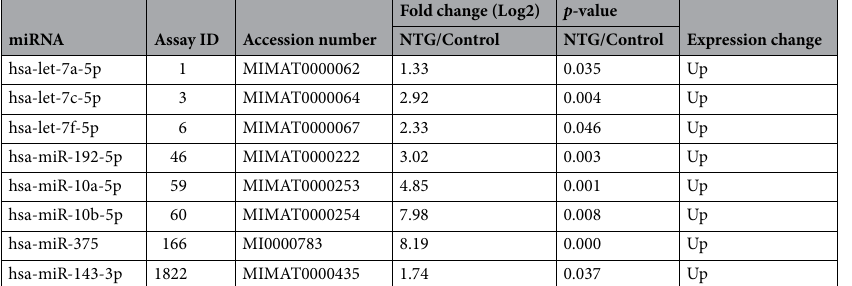
Expression changeNTG/Control